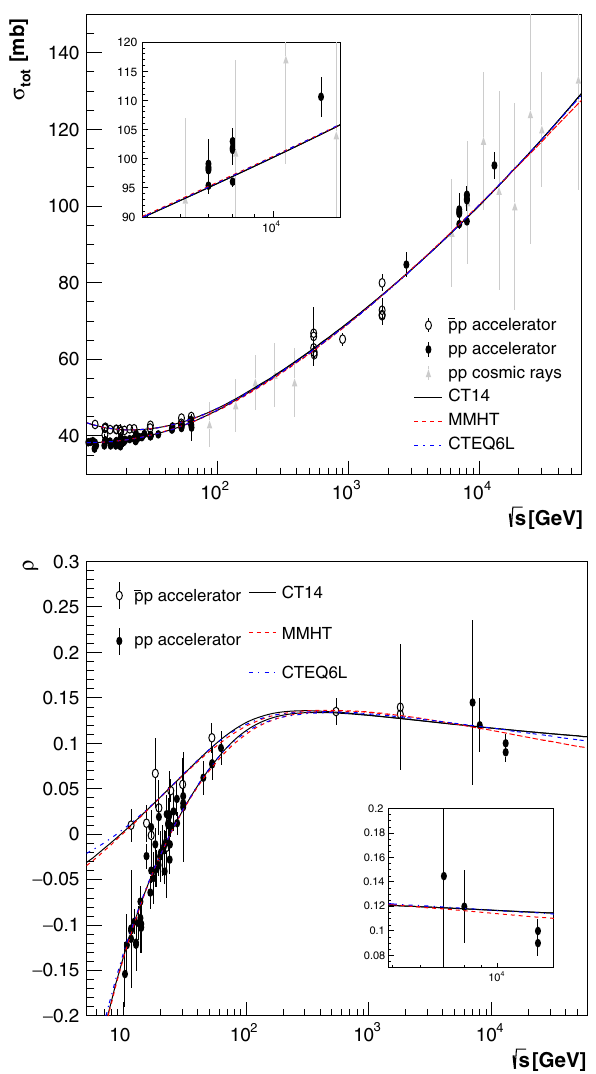
/ barpp ρ pp / barpp data with statistical weighting Fig. 10 Fits to σ pp √ √ tot and factors 5 and 2 in the TOTEM data on σ tot at 8 TeV and 13 TeV, respectively. See